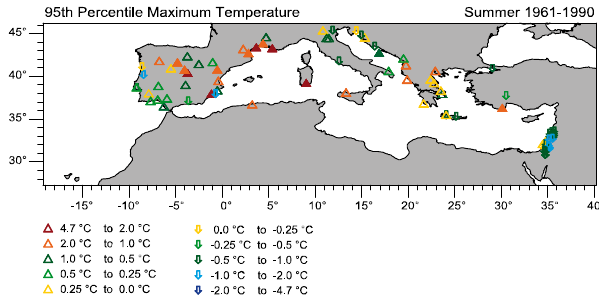
Figure 2: Trends of the 5 th percentile of minimum temperature in winter (December to February) for the period 1961-1990. Colour-filled symbols indicate significant trends at the 90% level.